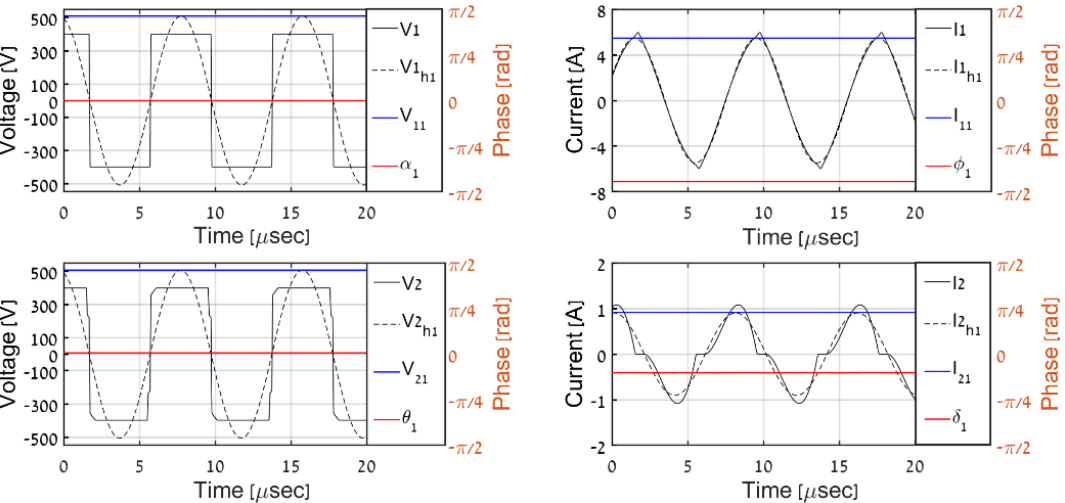
Figure 10. Simulation results, P O = 200 W.